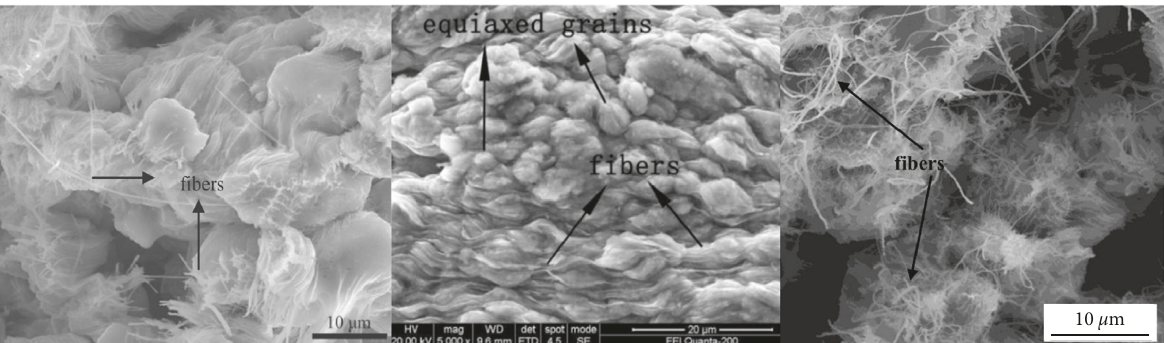
Figure 3: SEM image of fracture morphology of superplastically deformed Al alloys [41, 42, 57].